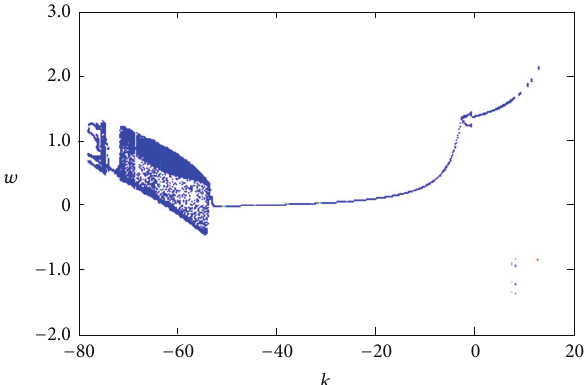
Figure 5: Bifurcation diagram varying with 𝑘 when 𝜎 = 0.0315.